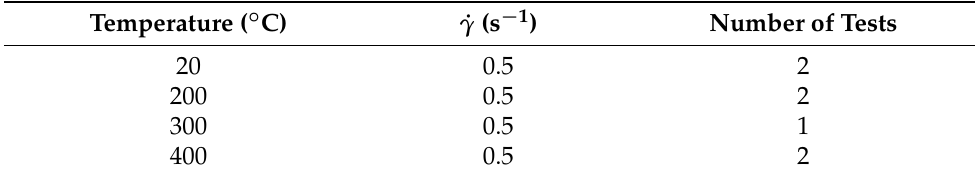
Table 4. A macroscopic analysis of the experimental curves combined with microstructural characterization of each condition tested was conducted. Table 4. Monotonic test conditions until